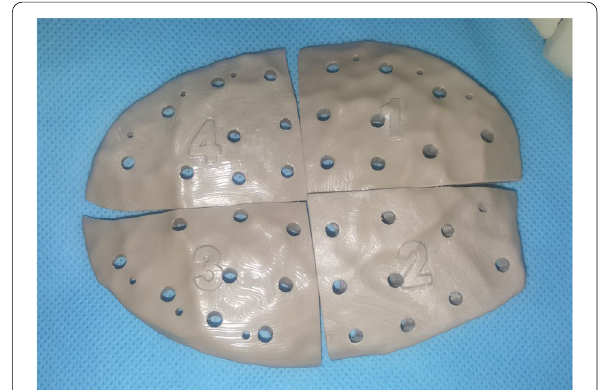
Fig. 4 The printed patient-specific PEEK implants